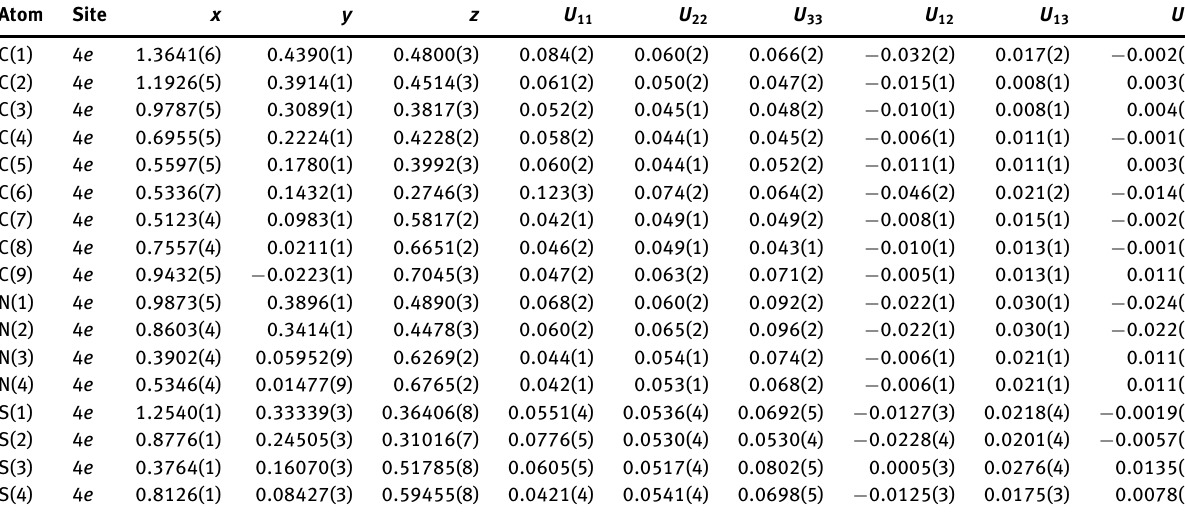
Table 3: Fractional atomic coordinates and atomic displacement parameters (Å 2